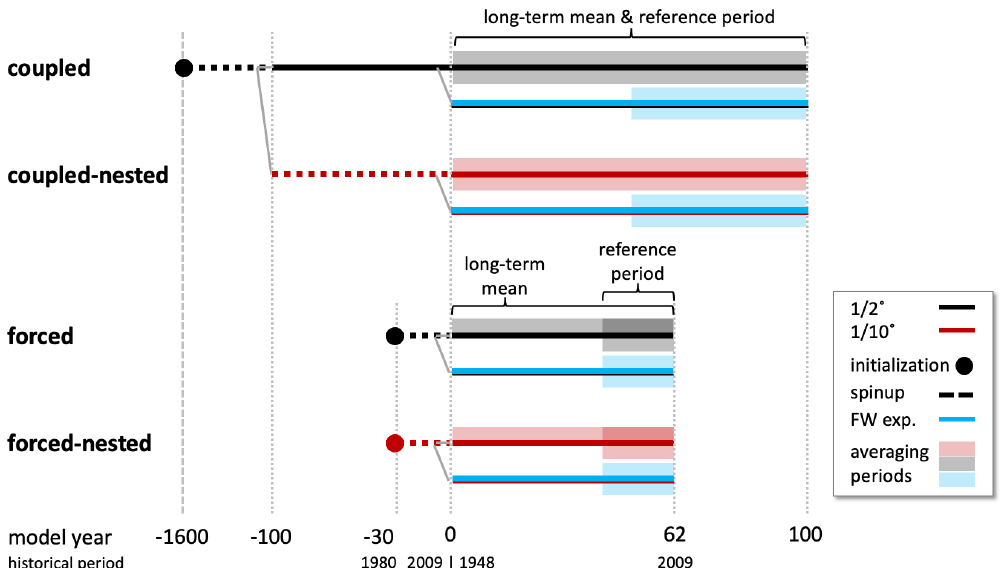
Figure 2. Sketch of the experiment setup showing the spinup, branching off, and duration of all model simulations. All simulations were initialized using the PHC3.0 ocean climatology (Steele et al., 2001), starting from rest. Coupled non-eddying and eddying experiments share the same low-resolution 1500-year-long spinup; coupled freshwater experiments were branched off of the respective control run after 10 years. See main text for